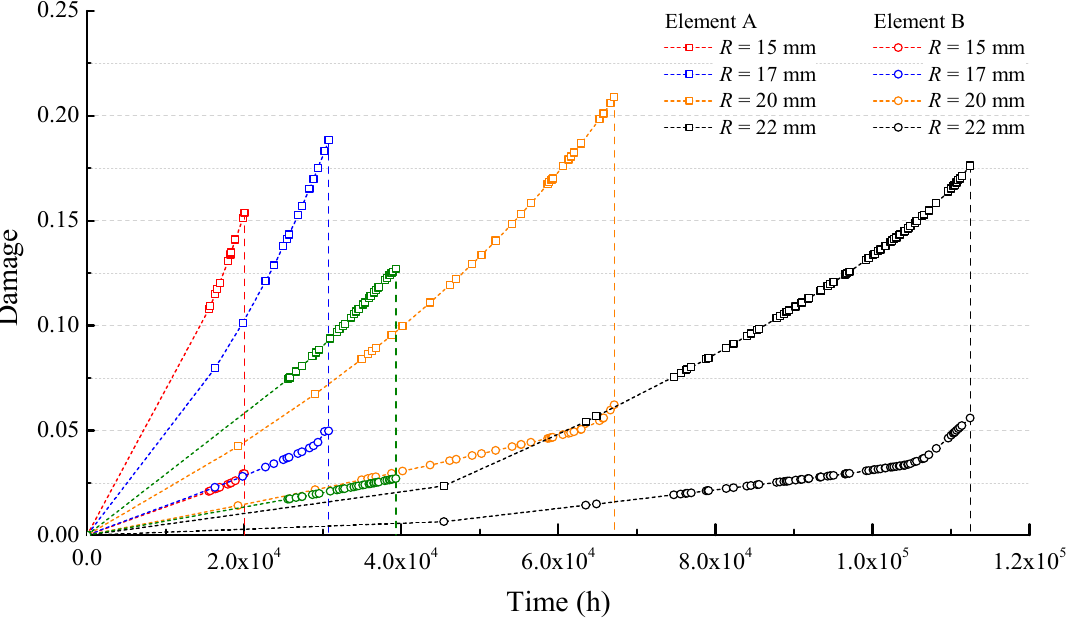
Figure 6. The damage of elements A and B vs time in the case of different bending radii R .